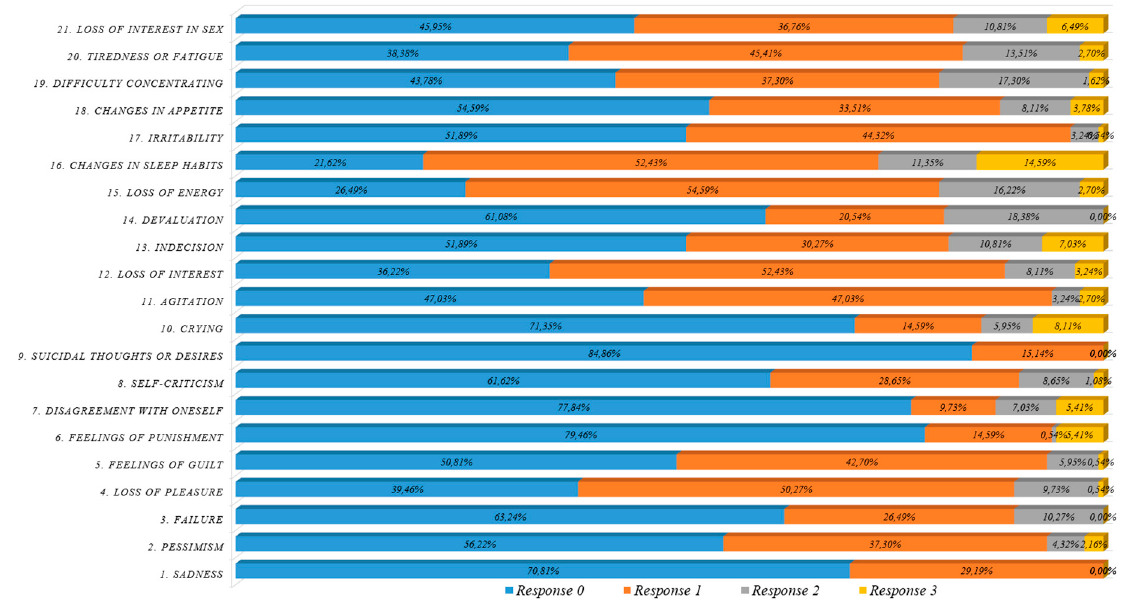
Figure 7. BDI-II questionnaire responses by response level (staff & faculty).